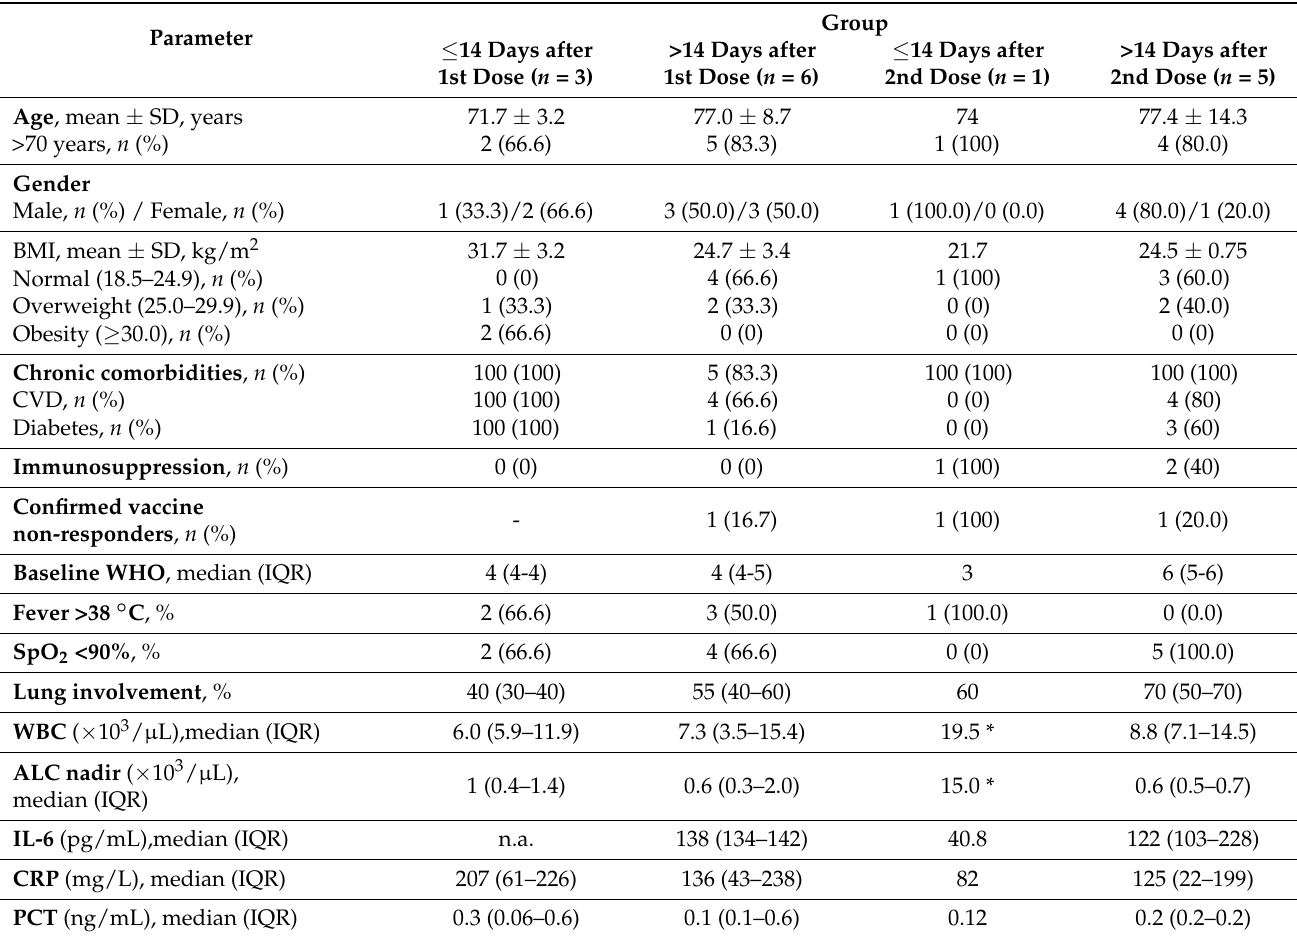
Table 4. The clinical and laboratory characteristics of patients with fatal COVID-19 who have received at least one dose of COVID-19